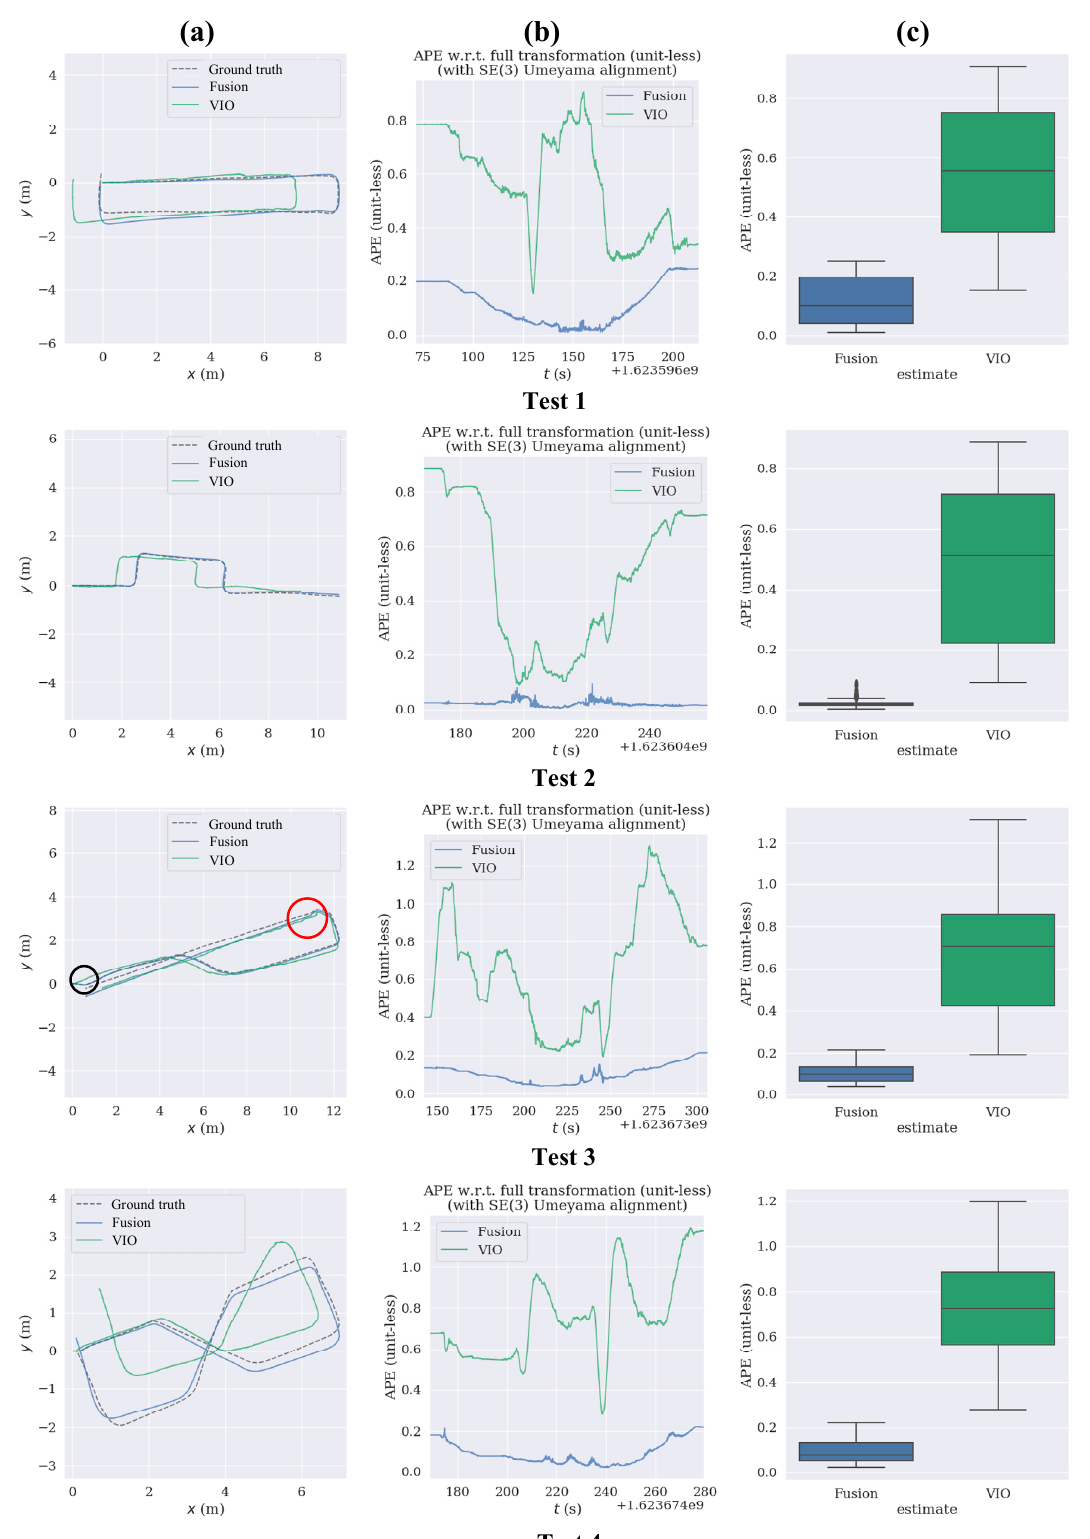
Figure 7. APE values comparisons (RES) of tests 1 to 4 between our method and the VIO from the Realsense T265. Column ( a ) shows comparisons of the absolute localization error between our method and VIO in the error maps. Column ( b ) shows comparisons of the curves of APE over time. Column ( c ) shows comparisons of the box plots.